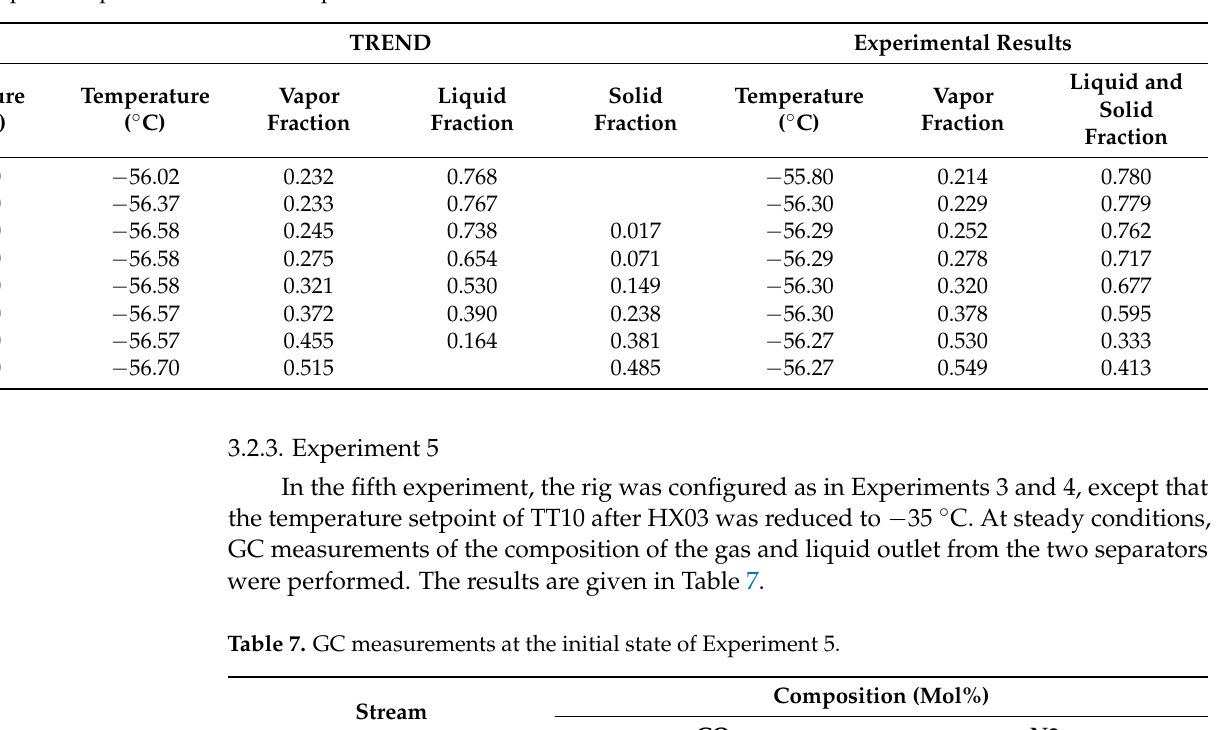
Table 7. GC measurements at the initial state of Experiment 5.